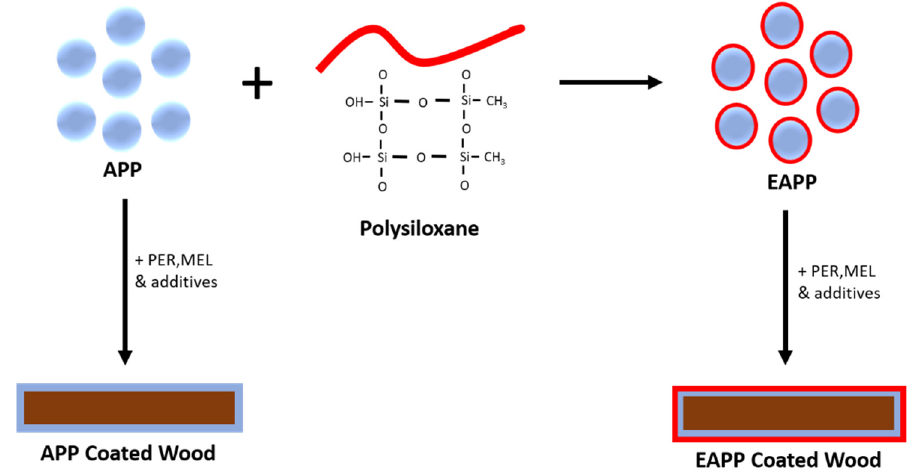
Figure 1. Scheme showing APP encapsulation and coating on wood substrate.